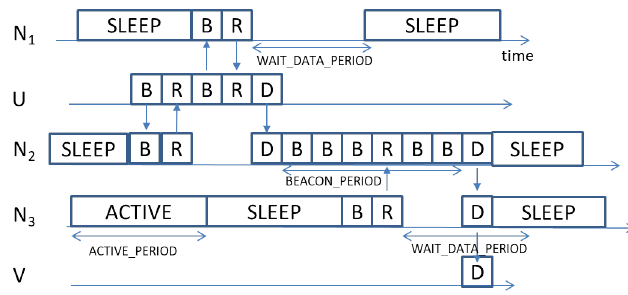
Figure 2. Illustrative example for data routing in ODYSSE. The node U is a source node sending a packet to node V. The node U has as neighbors nodes N 1 and N 2 . Node N 2 has as neighbors nodes U and N 3 , while N 3 has as neighbors nodes N 2 and V. Node V has as neighbors node N 3 . Messages are denoted: “B”: Beacon, “R”: Reply, “D”: “Data”, “SLEEP”: sleep period, “ACTIVE”: active